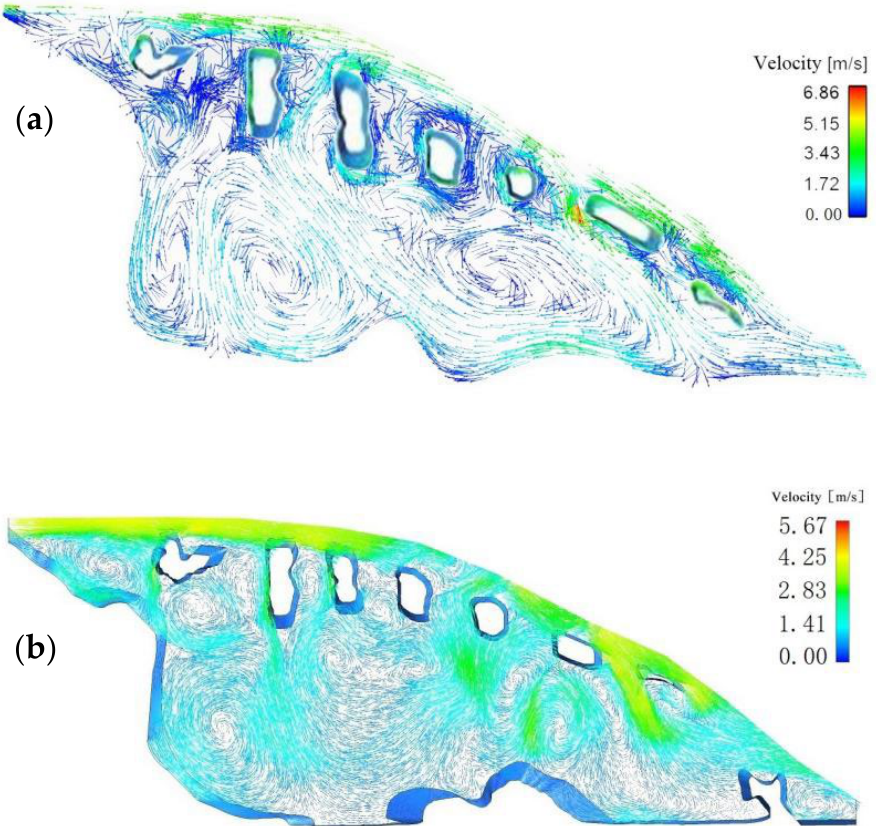
Figure 3. Depth-averaged velocity from ADCP (Acoustic Doppler current profiler) field measurements and the CFD (Computational fluid dynamics) model results. ( a ) Flow pattern diagram in Area Ⅰ scanned using an ADCP. Mapping was conducted following the methods of Fischer et al. [36]. ( b ) Flow velocity simulation result at inflow velocities v 0 = 4.0 m/s.